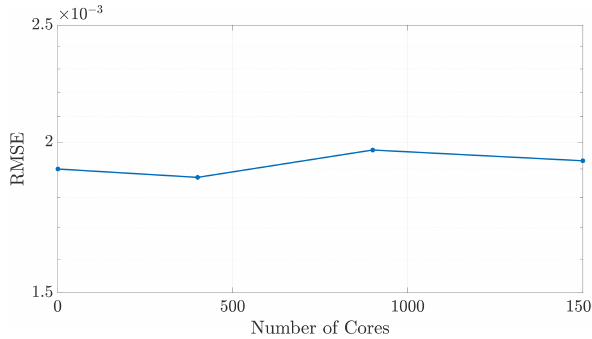
Figure 3. The algorithm does not incur noteworthy changes in er- ror, as a function of N (cid:127) for the 2-D checkerboard DDC method considered here, nor in any of the simulations that were